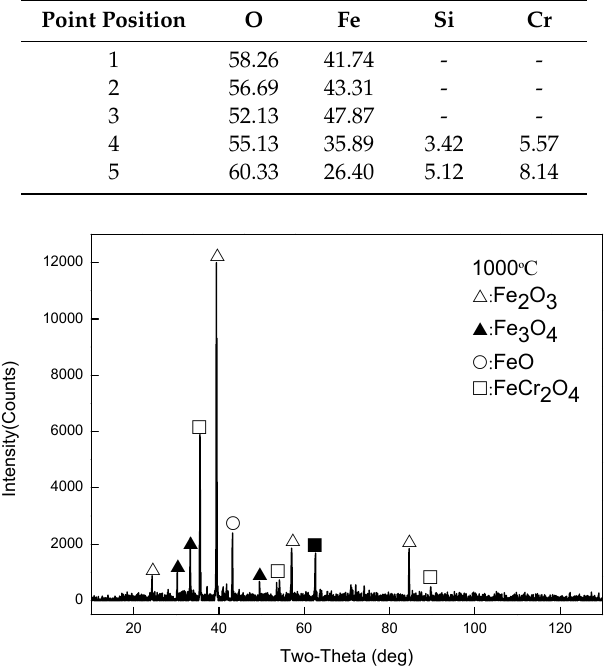
Figure 9. XRD data for the oxide scales obtained at 1000 °C.